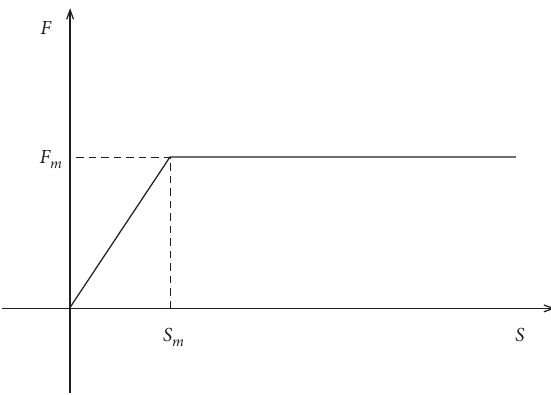
Figure 1: General soil spring model.